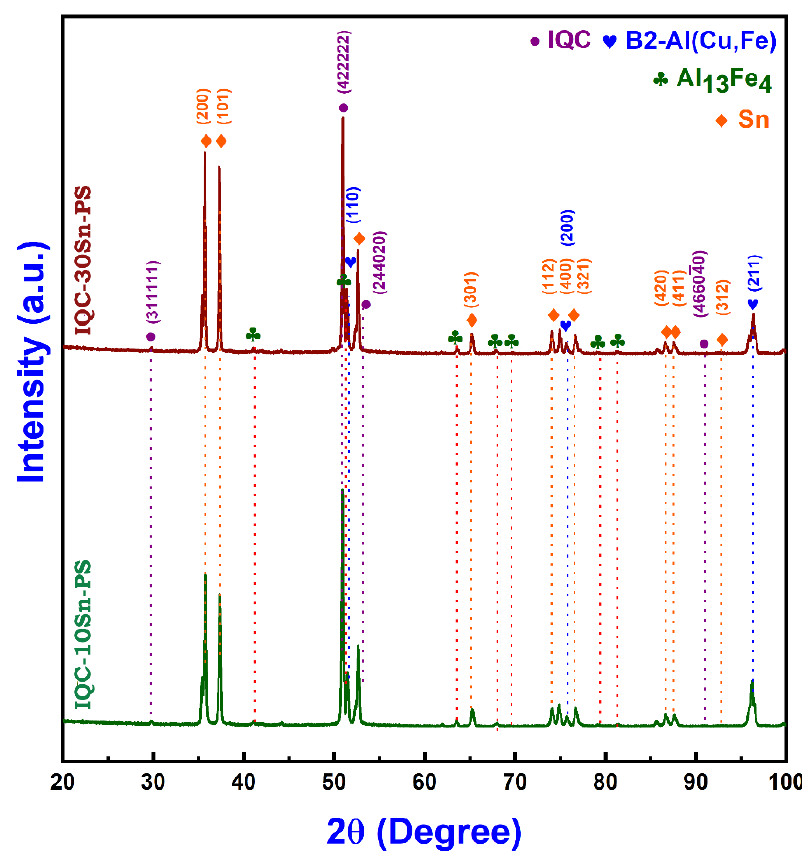
Figure 5. Phase analysis of IQC-Sn composites pressureless-sintered (IQC-10Sn-PS and IQC-30Sn-PS) at 800 °C (1073 K) for 10 h.